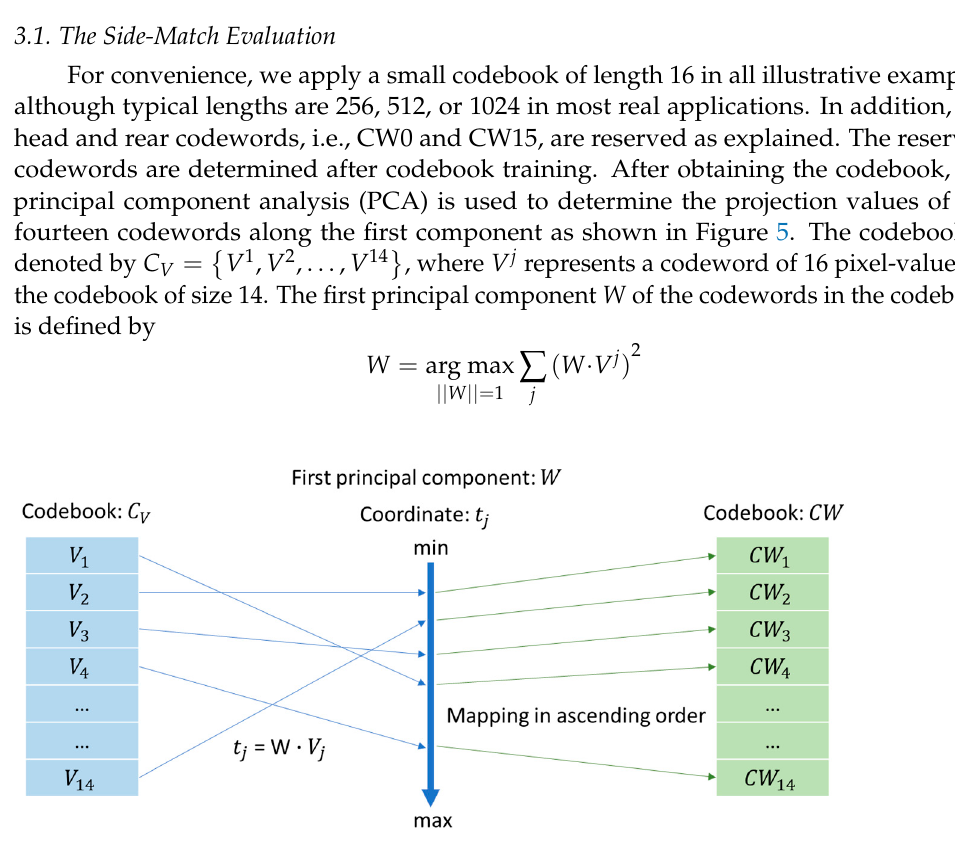
Figure 5. Illustration of the codebook sorting.